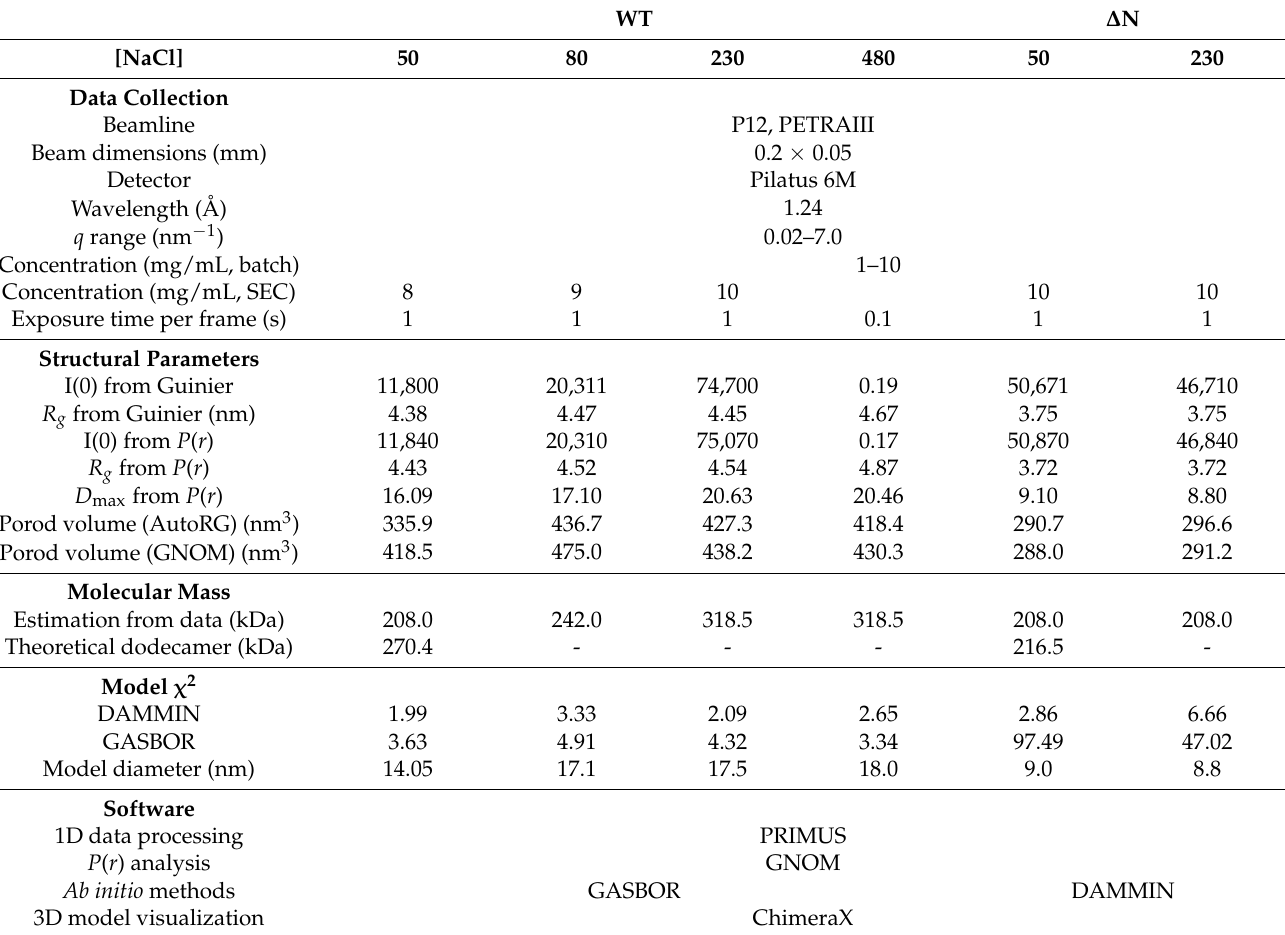
Table 2. Data collection and SAXS parameters for DgrDps WT and ∆ N variants. WT ∆